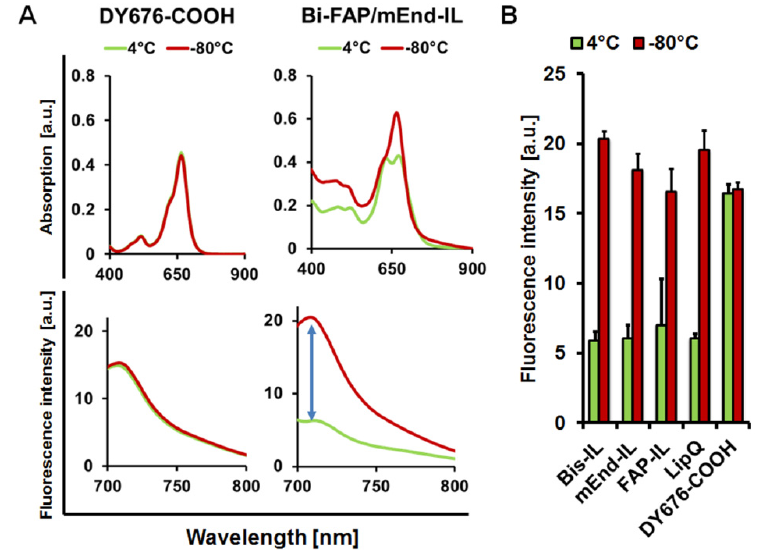
Figure 2. Spectroscopic validation of liposome quenching and activatability. ( A ) The free dye, DY-676-COOH at a concentration equivalent to the dye content in 100 nmol LipQ, gives a single absorption maximum and high fluorescence emission irrespective of storage at 4 °C or -80 °C. Contrarily, intact liposomes are fluorescence quenched and show a blue-shifted double absorption maximum and low fluorescence emission (4 °C, green lines). Upon freeze-damage at -80 °C the encapsulated DY-676-COOH is released and diluted in the surrounding solvent resulting in a single absorption maximum and almost 3-fold increase in fluorescence emission (red lines). ( B ) Semi-quantitative levels of fluorescence emission of intact (4 °C, green bars) and freeze-damaged liposomes (-80 °C, red bars). Each bar represents the mean of 3 independent measurements and standard deviation. Compared to the free dye all liposomes show significantly lower fluorescence when intact (p < 0.001 ) and an increase to almost the level of the free dye after activation. 3.3. Activatable Targeted Liposomes Are Selective for the Respective Target Cells In Vitro